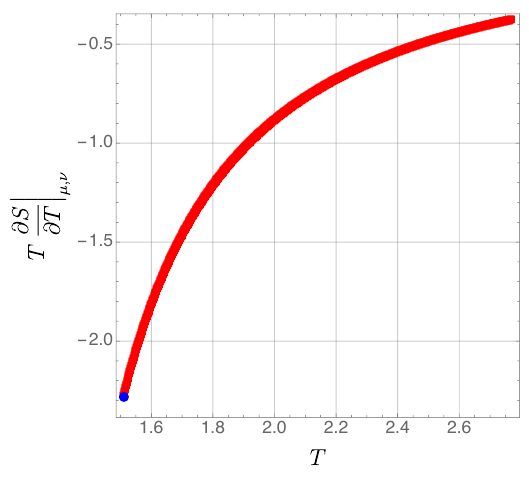
Figure 23 . Speci(cid:12)c heat of the C-metric like solution computed for (cid:12)xed boundary metric with (cid:22) = (cid:23) = 18. The blue disk denotes the C-metric solutions of section 4.5, while the red squares represents generalisations to di(cid:11)erent